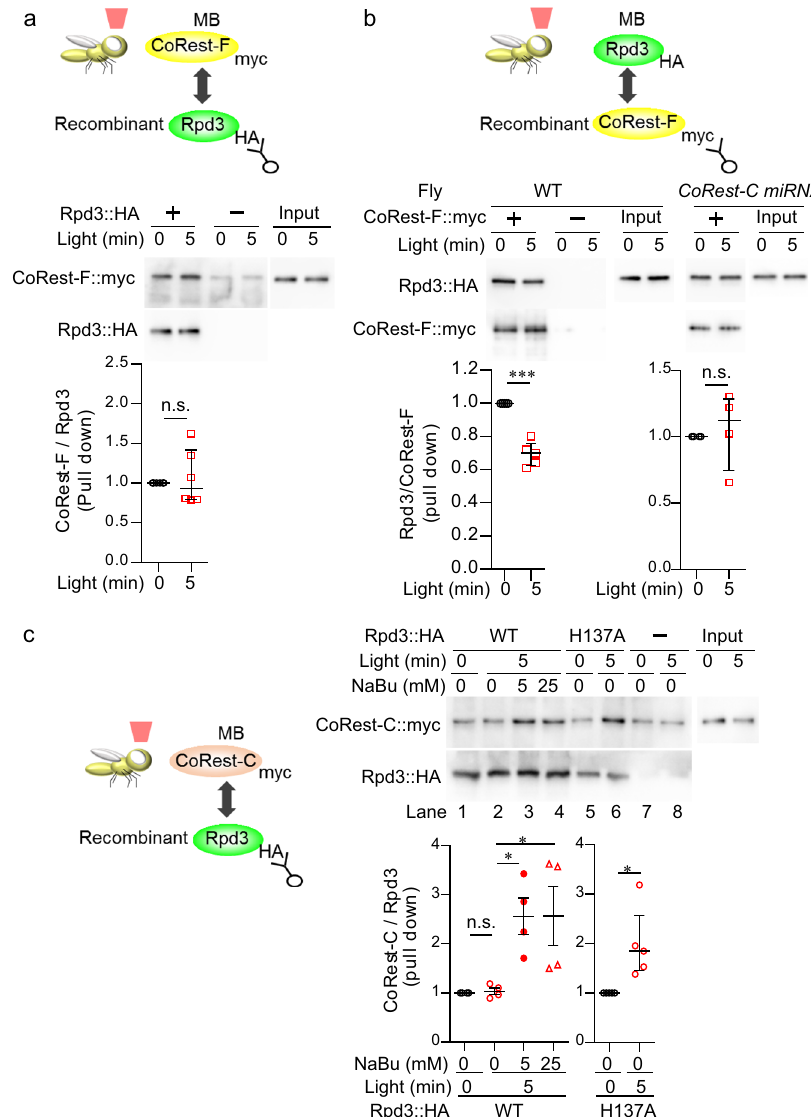
Fig. 4 Neural activation induces a molecular change in CoRest-C. a Binding of CoRest-F proteins to the recombinant Rpd3 proteins was not altered by optogenetic activation. The fl ies carrying MBsw, UAS-CsChrimson , and UAS-CoRest-F::myc were fed RU, and illuminated with red light. The head extracts were pulled down with the recombinant Rpd3::HA, which was expressed in Sf9 insect cells. Two-sided Mann – Whitney U -test, P = 0.6475; n = 6. b Binding of Rpd3 proteins to the recombinant CoRest-F proteins was reduced by optogenetic activation, depending on CoRest-C. Rpd3::HA and CsChrimson were expressed by MBsw in WT fl ies or in fl ies carrying UAS-CoRest-C-miRNA , and the fl ies were illuminated with red light. The head extracts were pulled down with recombinant CoRest-F::myc, which was expressed in E. coli . (Left) Two-sided Mann – Whitney U -test, P = 0.0007, n = 5. (Right) Two-sided Mann – Whitney U -test, P = 0.7481, n = 4. c Binding of CoRest-C proteins to the recombinant Rpd3 proteins was increased by optogenetic activation, when the deacetylation activity of Rpd3 was inhibited. CoRest-C::myc and CsChrimson were expressed by MBsw, and the fl ies were illuminated with red light. The head extracts were pulled down with recombinant Rpd3::HA (WT proteins or proteins carrying H137A mutation), which was expressed in Sf9 insect cells. The indicated concentration of the HDAC inhibitor sodium butyrate (NaBu) was included in the reaction. (Left) One-way ANOVA ( P = 0.0078; n = 6) followed by Tukey ’ s multiple comparisons (two sided) was performed. (Right) Two-sided Mann – Whitney U -test, P = 0.0369; n = 6. The antibodies for the indicated epitope tags were used in a western blot analysis. Data are represented as mean ± s.e.m. n.s., not signi fi cant, P > 0.05; * P < 0.05; *** P < 0.001, which is based on experimental replicates using different pooled samples, and the number is indicated as n above. Source data are provided as a Source Data fi